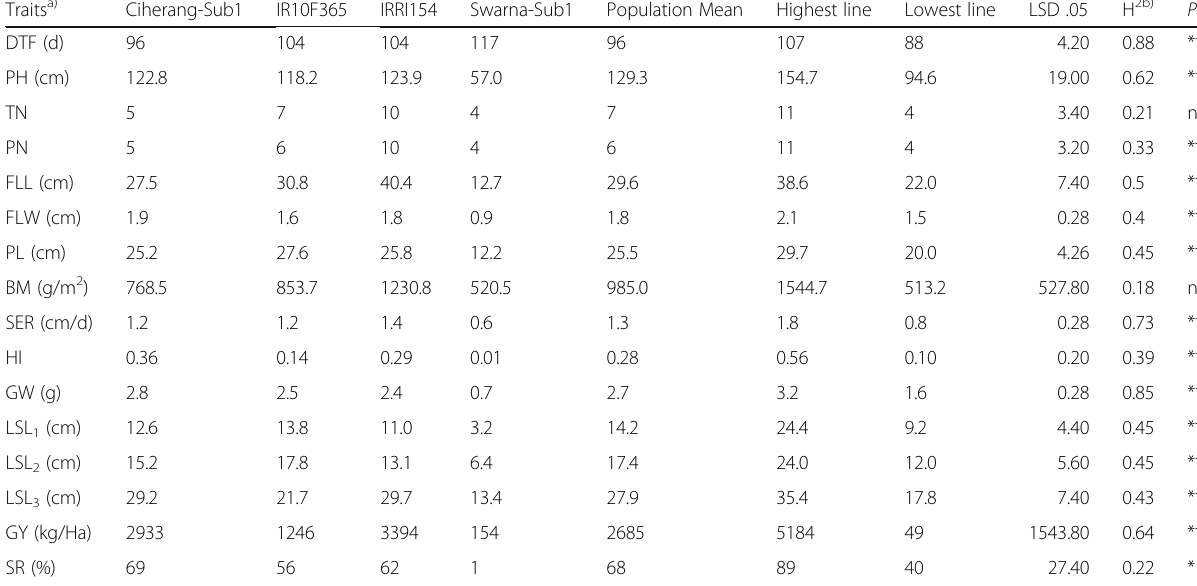
Table 1 Descriptive statistics of each trait in the mapping population, parents, and checks under stagnant flooding Traits